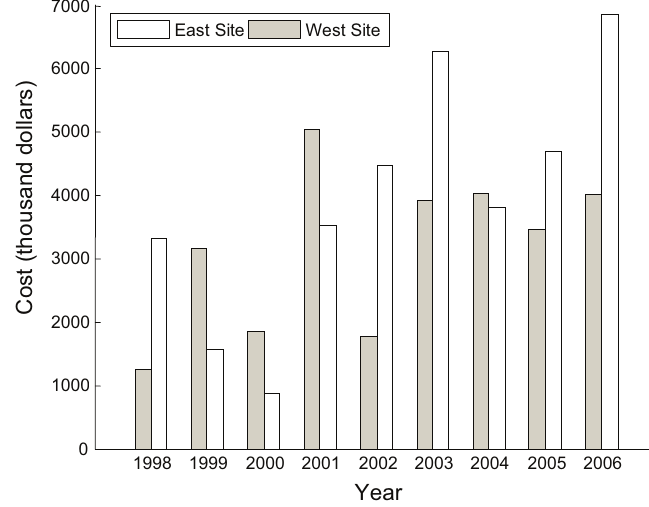
figure 1. maintenance cost of